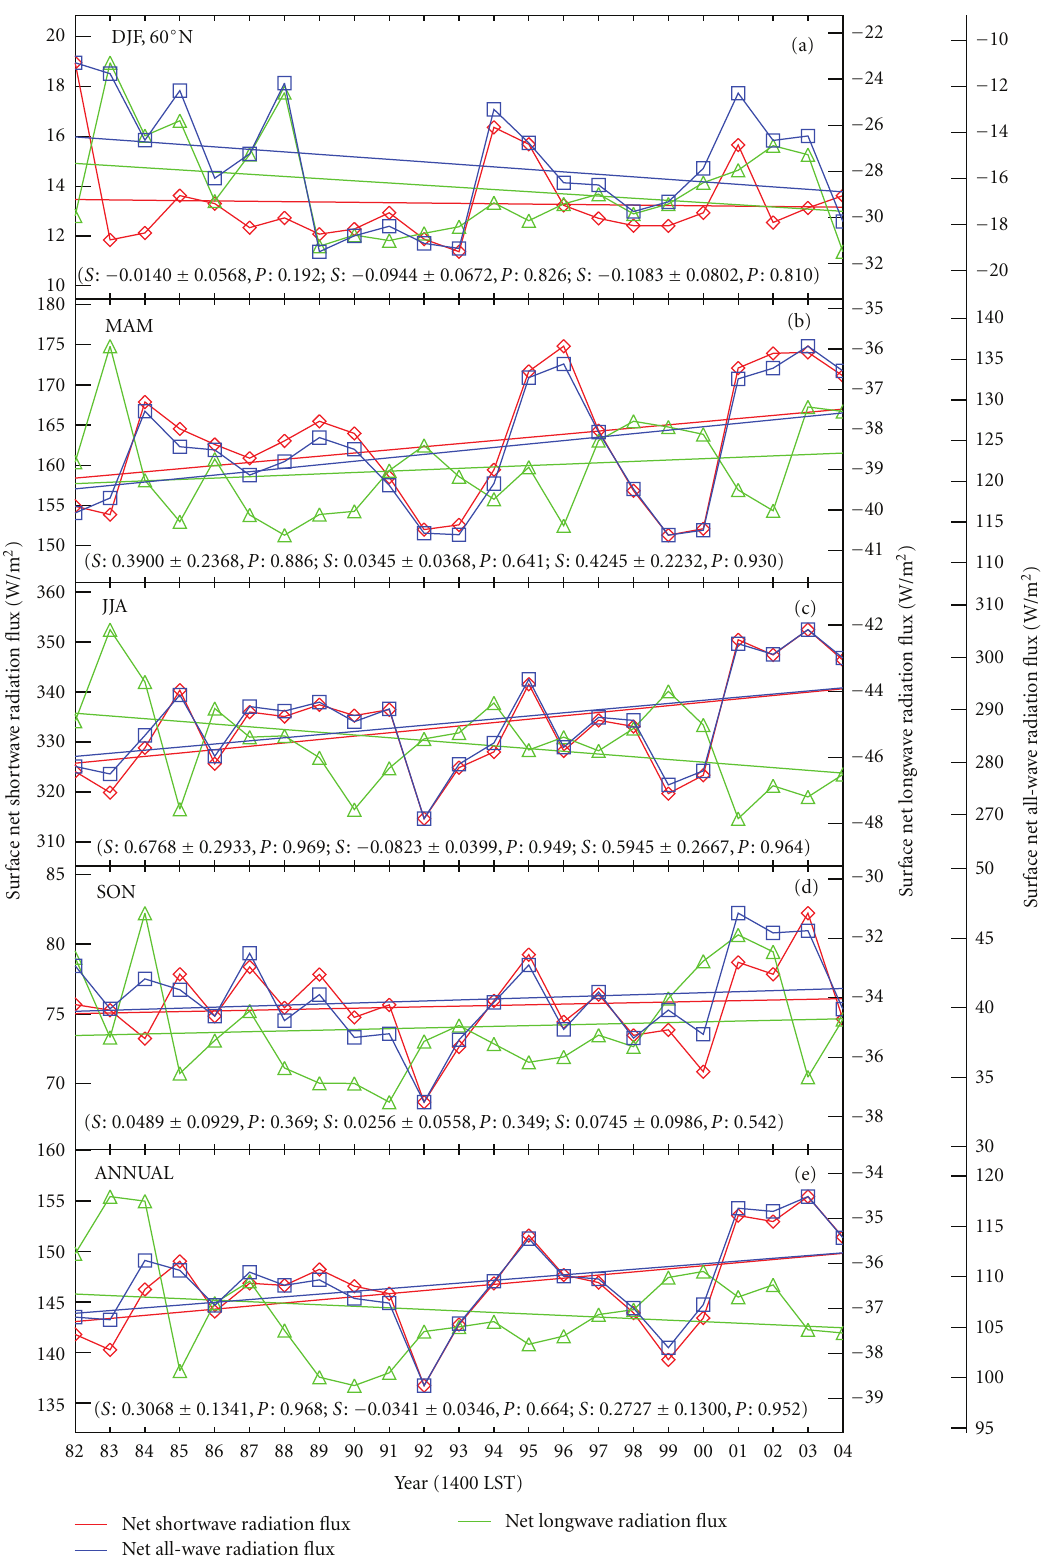
Figure 10: As in Figure 3, but for net shortwave, net longwave, and all-wave radiative fluxes at the surface. The first pair of S and P denotes the net shortwave radiation trend (red), the second pair is for the net longwave radiation trend (green), and the third pair represents the net all-wave radiation trend